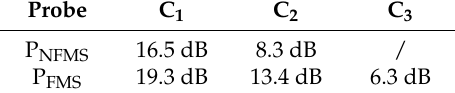
Table 1. The SNR comparison for P NFMS and P FMS (magnetization current = 40